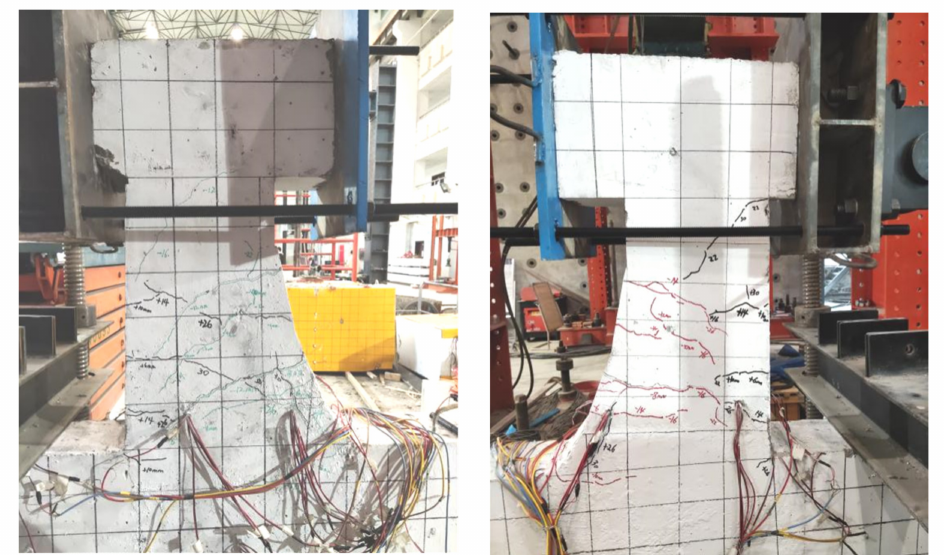
Figure 14. Crack development diagram of the coupling